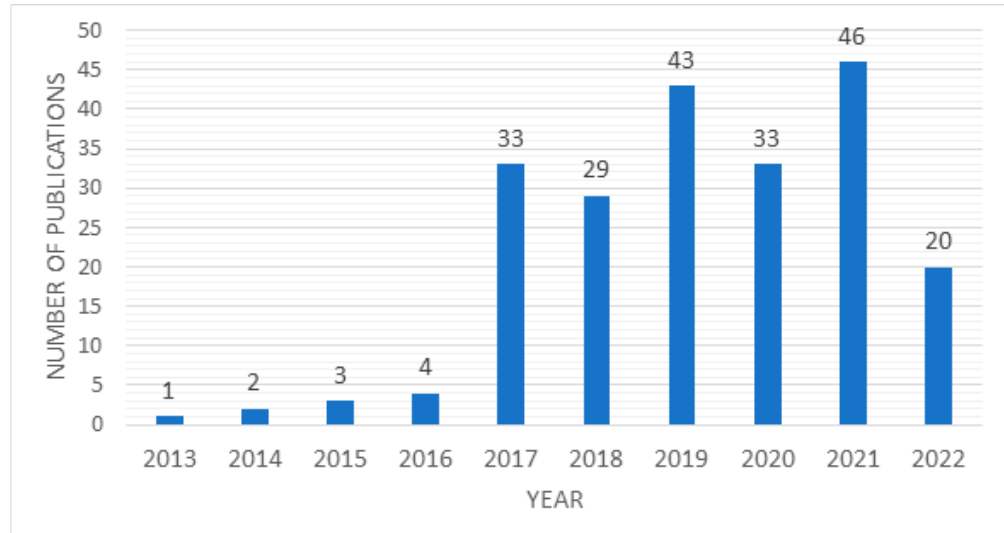
Figure 20. A number of papers by publication year.